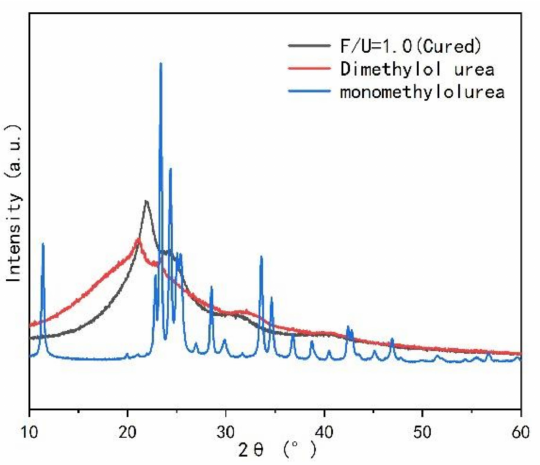
Figure 5. Comparison of XRD patterns of monomethylol urea and dimethylol urea with cured UF